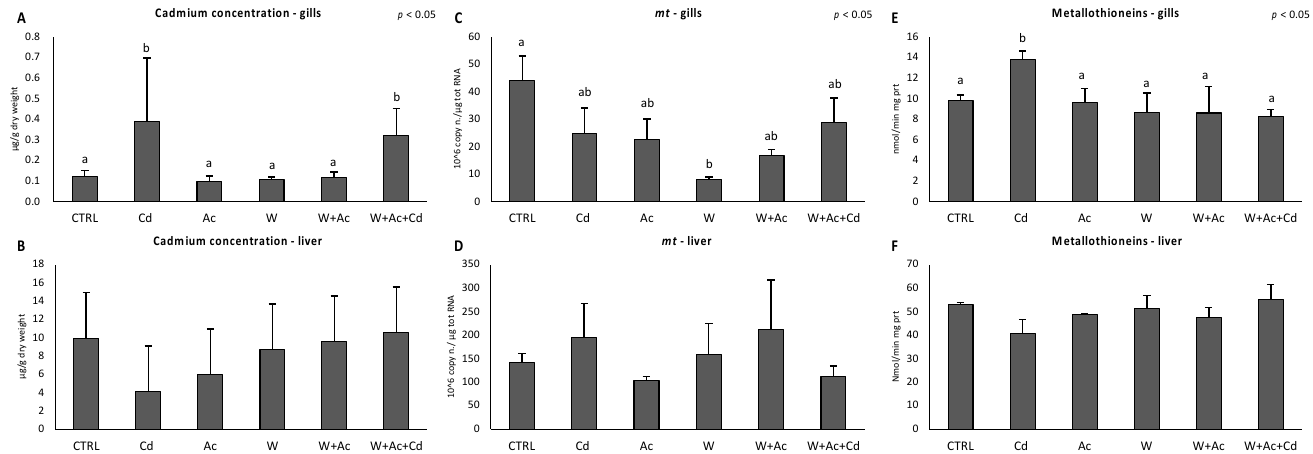
Figure 1. Cadmium concentrations ( A , B , µg/g dry weight), metallothioneins mRNA ( C , D ) and protein levels ( E , F ) in gills ( A , C , E ) and livers ( B , D , F ) of T. bernacchii exposed to different experimental conditions. Different letters highlight significant differences between groups of means. Data are expressed as mean ± standard deviations, n = 5.